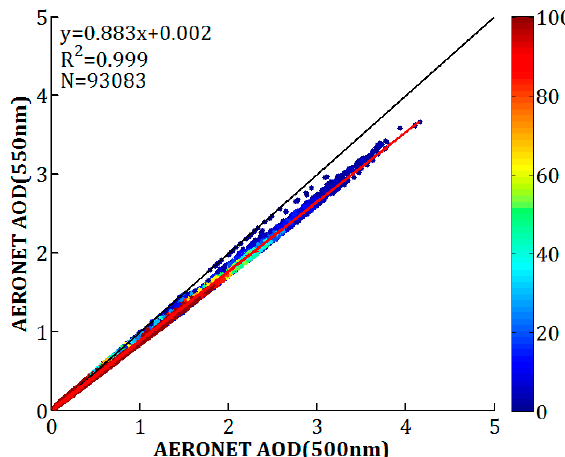
Figure 5. Spectral transformation model of the AOD. The black and red solid lines are the 1:1 line and regression line, respectively.